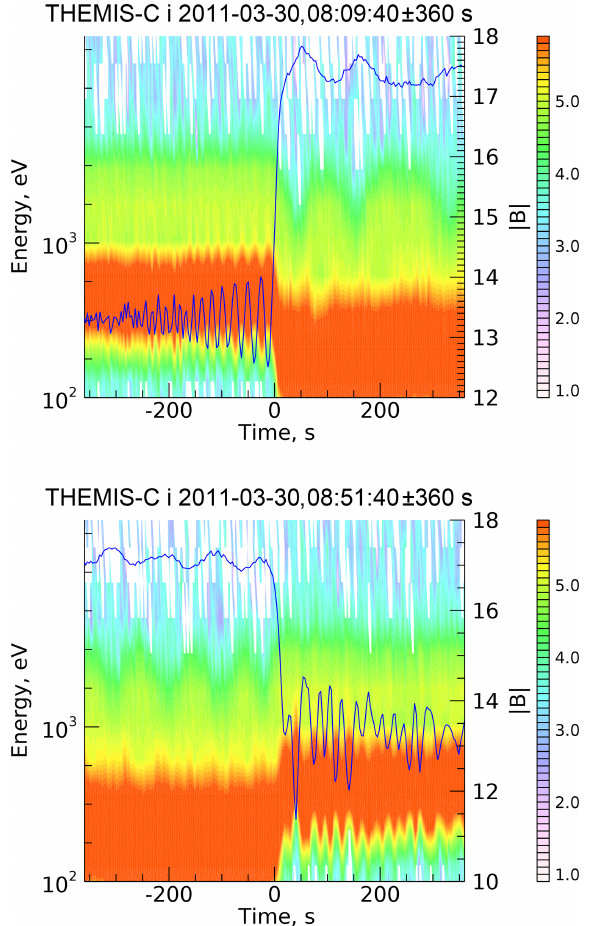
Figure 3. Earth bow shock crossings by THEMIS-C on 30 March 2011. Magnetic profiles (magnitude) and ion spectro- grams are plotted together.